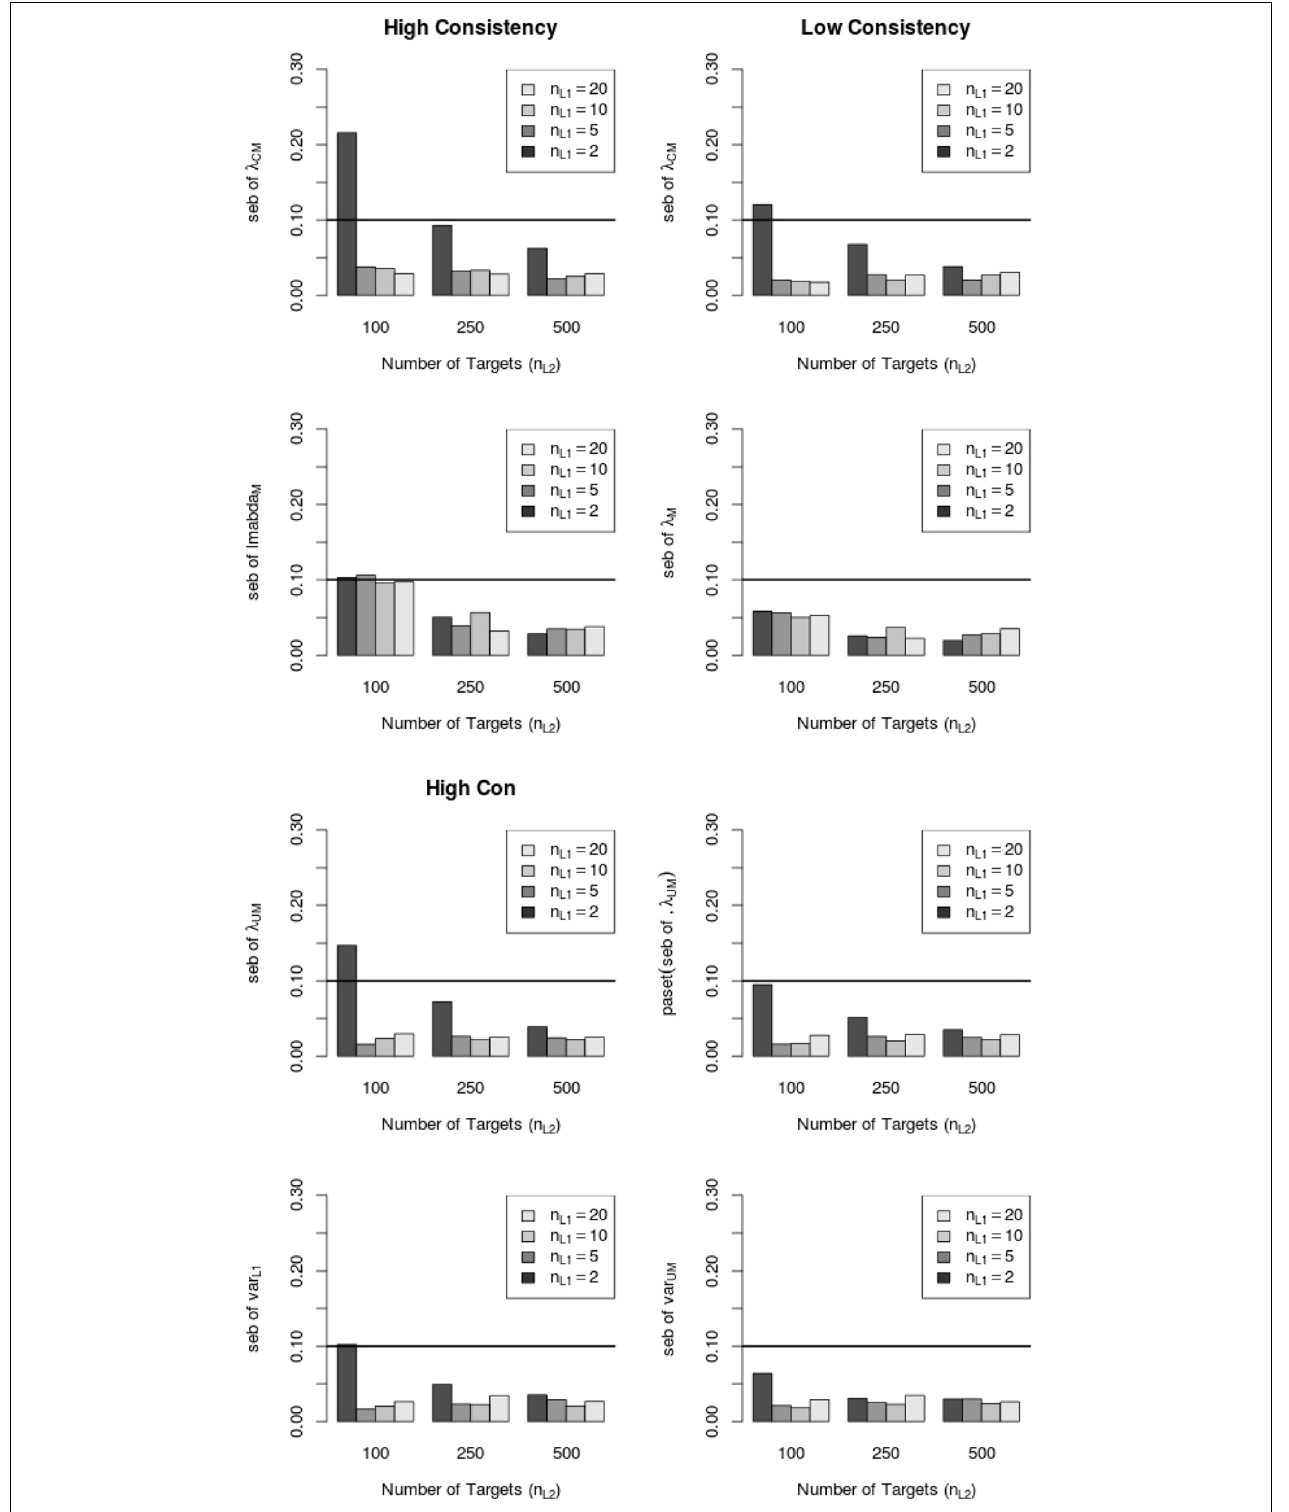
parameters; λ M = method factor loading parameters; λ UM = unique method factor loading parameters; var L 1 variance of the unique method